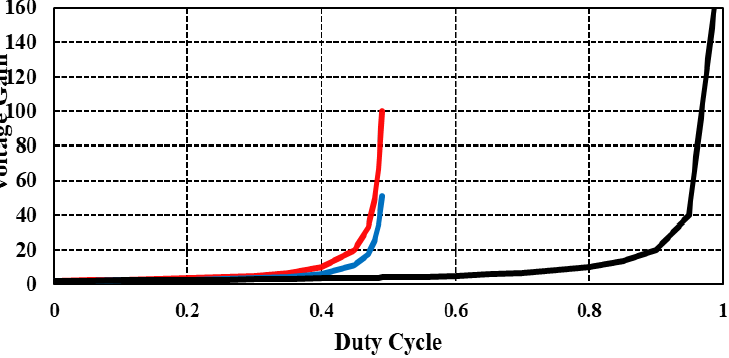
Figure 21. Efficiency curve of the proposed converter under different load conditions.